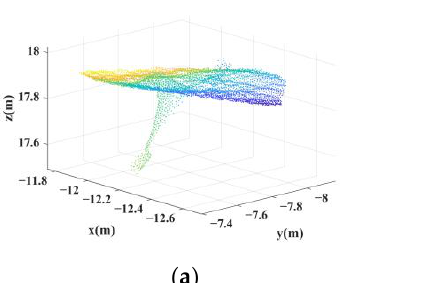
( b ) Figure 7. Suspected anchor rod points of initial identification. ( a ) Unclustered suspected anchor rod points in the test area. ( b ) Clustering results of suspected anchor rod points. ( a ) ( b ) Figure 8. Precise screening results after clustering. ( a ) Clusters with anchor rod points. ( b ) A clus- ter containing anchor rod points. In this test area, 34 sets of anchor rod point clouds were obtained. To validate the results of automatic identification, manual discrimination was used to manually count the number of real anchor rods in the test area. The test area contained 36 anchor rods, 2 of which were located in the same point cluster due to their close proximity, and 1 an- chor rod was not detected because its exposed length was significantly shorter than the exposed lengths of the others due to blasting and other construction-related factors. The method described in this paper is comparable to the number of manually identified an- chor rods, accurately identifies normal exposed supporting anchor rods, and has an ini- tial identification accuracy of 97.2% in this experimental area.